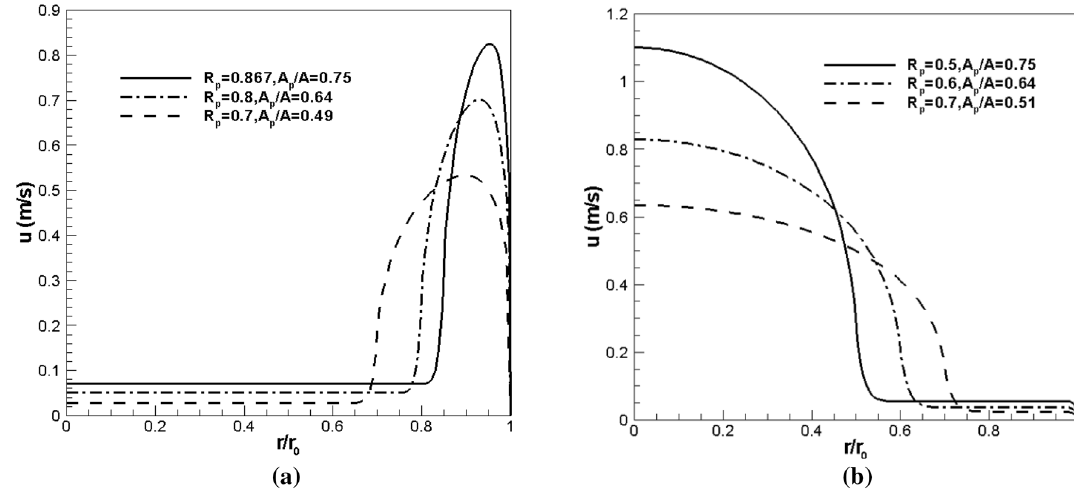
Fig. 11 Velocity profiles for different filling ratios in a central arrangement, b boundary arrangement